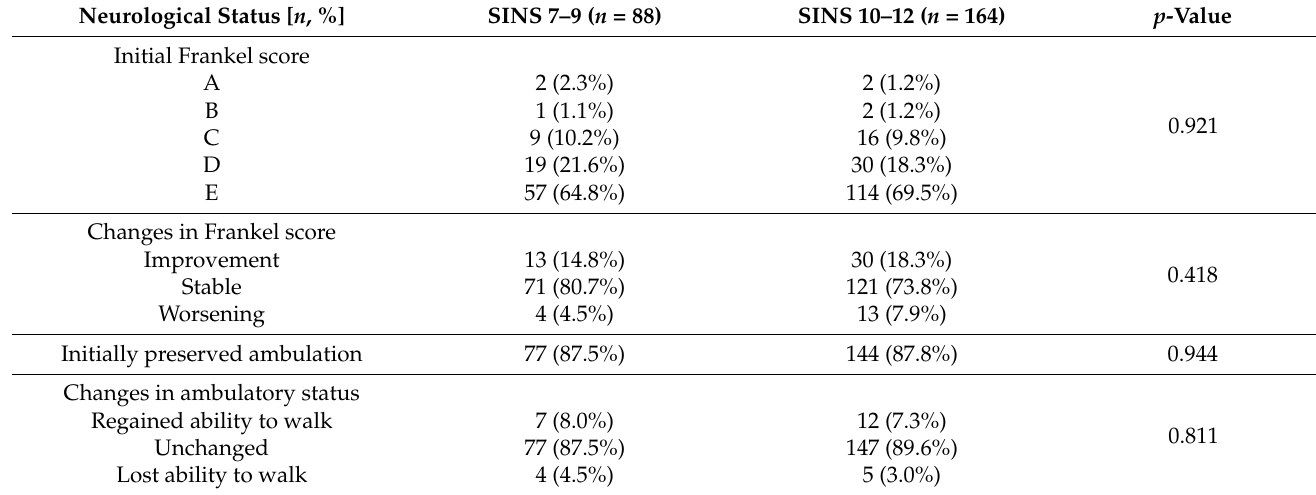
Table A6. Frankel score and ambulatory status in instrumented patients with SINS 7 to 9 and SINS